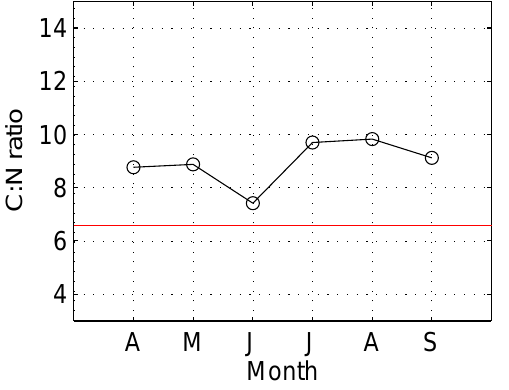
Figure 6. Average monthly C : N ratios for biological produc- tion (see Fig. 5) during the period of seasonal drawdown (April– September) of DIC and nitrate in the Iceland Sea. Then red line show the Redfield C : N ratio of 6.6.